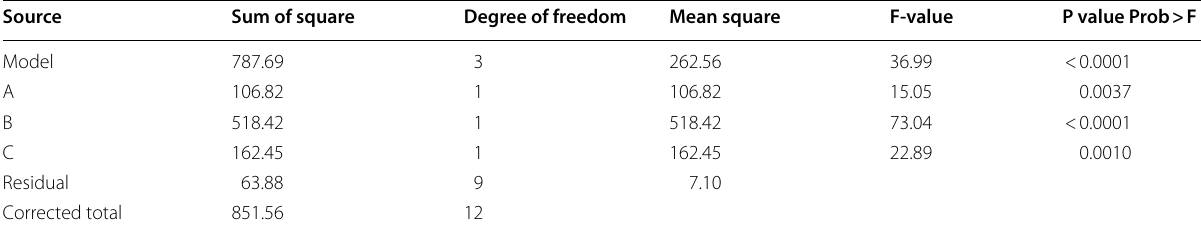
Table 3 The analysis of variance (ANOVA) for the response surface linear model regarding RL concentration (RL) Source Sum of square Degree of